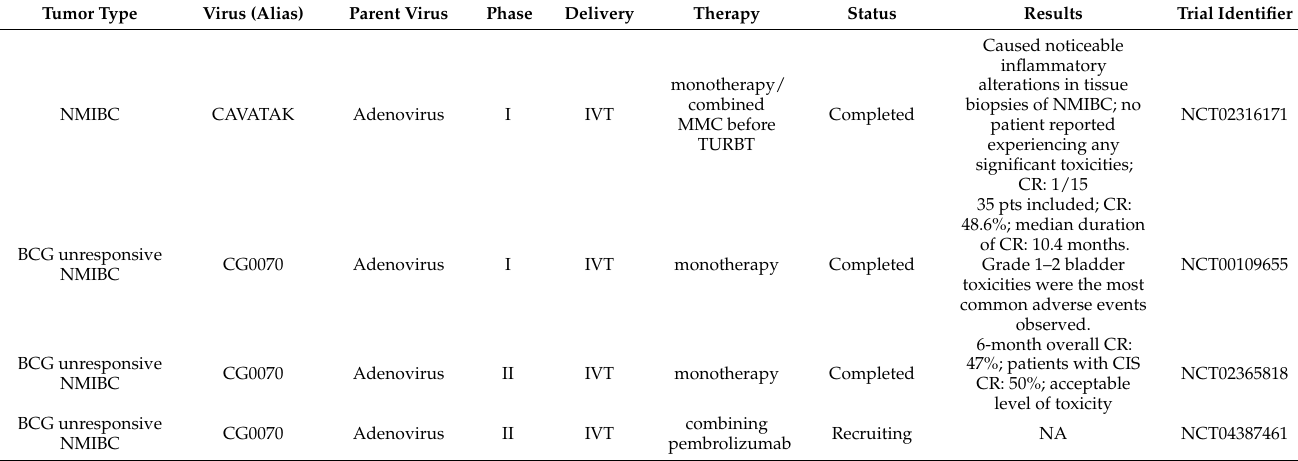
Table 2. Summary of clinical trials of oncolytic virus for bladder